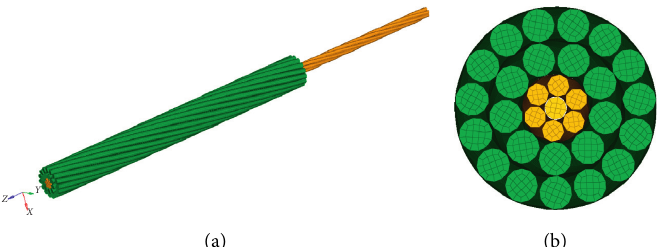
Figure 6: Meshing diagram of the steel core wire and aluminum stranded wire: (a) overall view; (b) cross-sectional view.